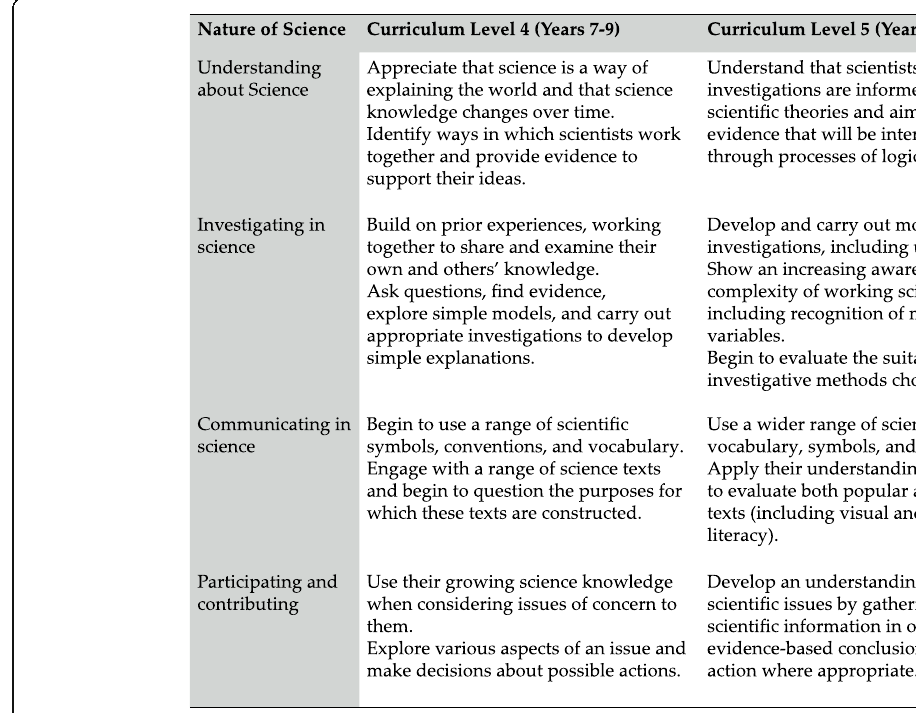
Fig. 1 New Zealand Curriculum, Nature of Science Learning Objectives, levels 4 and 5 (MoE